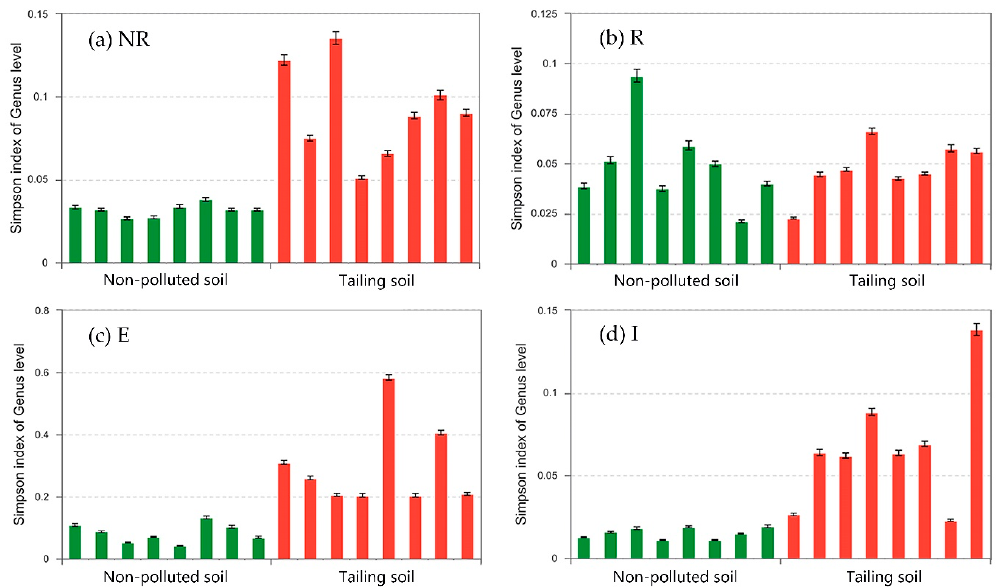
Figure 2. The bacterial community diversities in ( a ) the non-rhizosphere soil (NR); ( b ) the rhizosphere soil (R); ( c ) the external layer of the iron plaque (E) and ( d ) the internal layer of the iron plaque (I). The green bars are Simpson index values of 8 samples in the non-polluted soil (NP) while the red bars are those in the tailing soil (T). Error bars (SD, n = 8, p < 0.05) indicate the upper and lower bounds of the Simpson index in each sample.